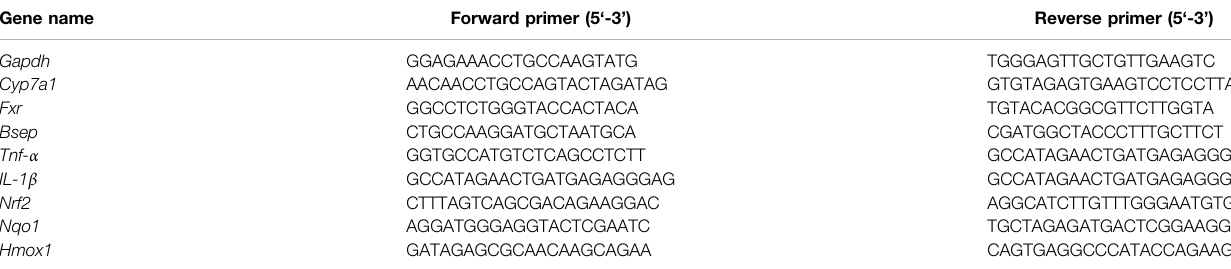
TABLE 1 | Speci fi c qPCR primers used in this study.